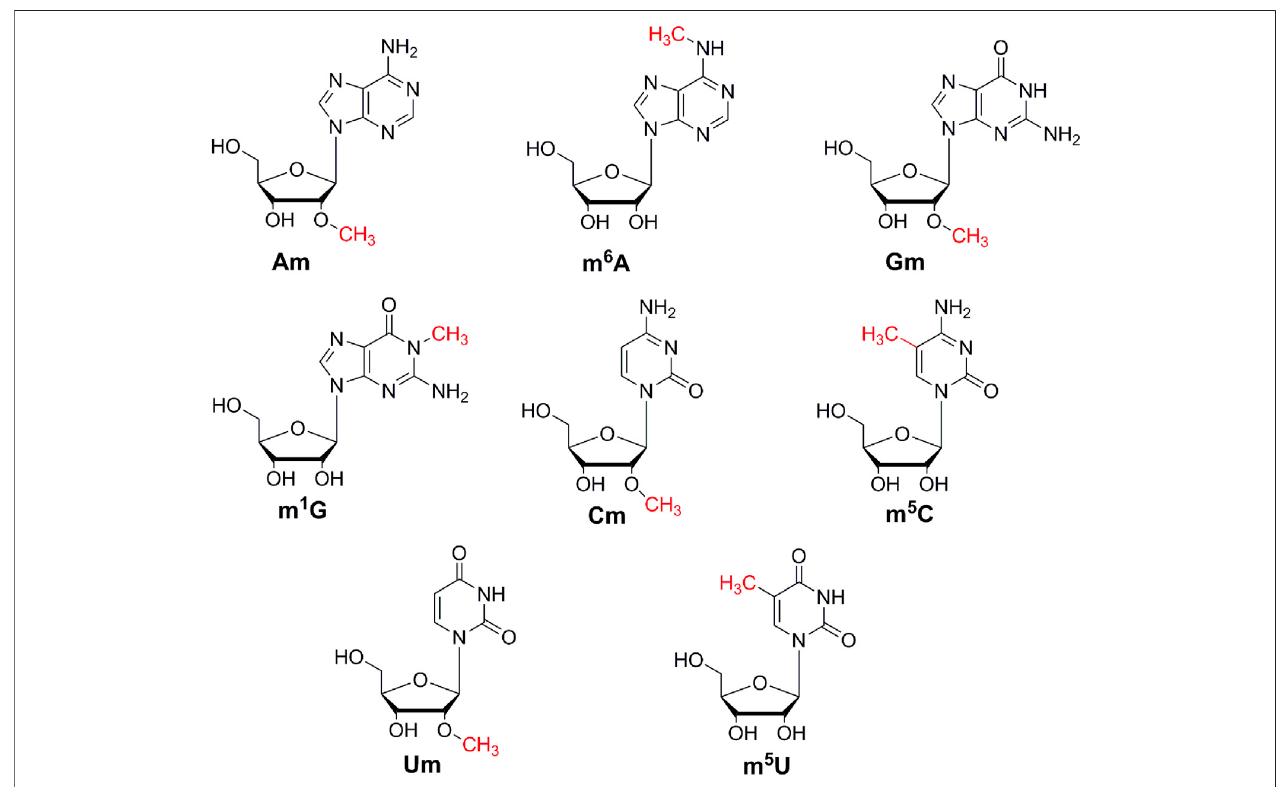
FIGURE 1 | The chemical structures of Am, m 6 A, Gm, m 1 G, Cm, m 5 C, Um, m 5 U.